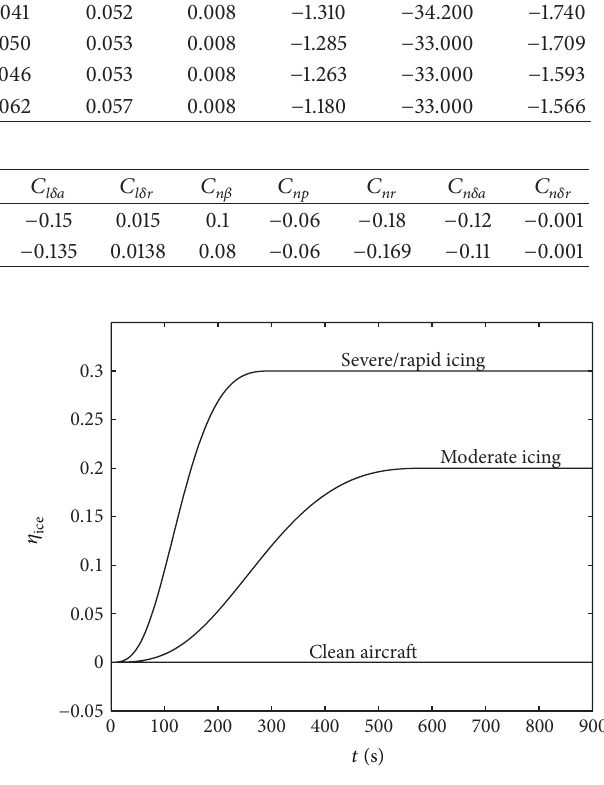
Figure 1: Two icing scenarios and the aircraft clean